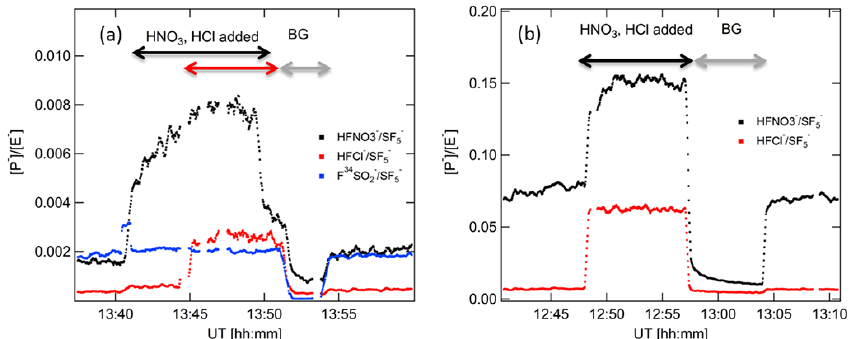
Figure 5. (a) In-flight calibrations of HCl, HNO 3 and SO 2 during TACTS/ESMVal. The time series of the ratio of product to reagent ion [ P − ] / [ E − ] for a 12min calibration sequence is shown. 5.8ppbv HNO 3 was added to the total sample flow for approximately 10min and stabilized after 4min. After 3min, 2.6ppbv HCl was added for 8min and showed a stable signal after 20s. 2.9ppbv SO 2 was added continuously. A background measurement (BG) was performed shortly after the calibration sequence with t 90 of 15s for SO 2 and HCl and 20s for HNO 3 , respectively. (b) In-flight calibration of HCl and HNO 3 during POLSTRACC. 2.6ppbv HCl and 3.5ppbv HNO 3 were added simultaneously for 8min. t 90 for the calibration signal is 15s for HCl and 20s for HNO 3 . Background measurements were performed shortly after the calibration with t 90 of 15–20s. Improvements of the calibration system between the two campaigns significantly enhance the speed of the calibration measurements. While inlet response times t 90 for background measurements were the same during the two campaigns, the calibration response time was